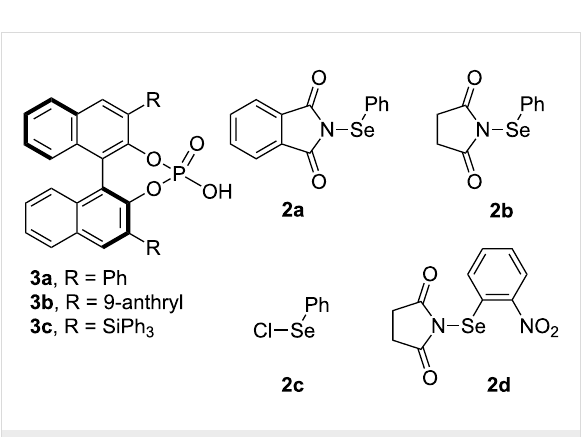
Figure 1: Catalysts and seleno reagents evaluated in this